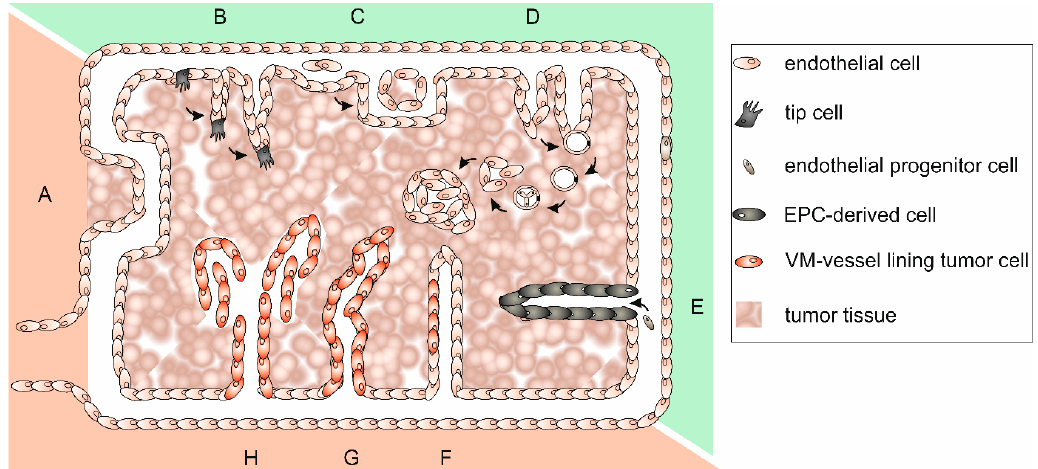
Figure 3. Different types of vascularization allow the blood supply of tumor tissue. Different types of vascularization can occur simultaneously and even merge: ( A ) co-option of preexisting vessels; ( B ) sprouting angiogenesis of endothelial cells; ( C ) intussusceptive angiogenesis; ( D ) glomeruloid angiogenesis; ( E ) vasculogenesis by recruitment of bone marrow-derived endothelial progenitor cells (EPCs); ( F ) in mosaic vessels, patches of tumor cells insert into the endothelium; ( G ) tubular type vasculogenic mimicry (VM) of tumor cells; and ( H ) patterned type VM of tumor cells. While angiogenesis ( B – D ), and vasculogenesis ( E ) depend on proliferation of ECs and bone marrow-derived EPCs, vessel co-option and VM ( F – H ) are EC proliferation-independent ways to support tumor growth. The recruitment of bone marrow-derived EPCs from distant parts of the body impairs radiation therapy, while vessel co-option and VM are unassailable to anti-angiogenic therapy. Vascularization mechanisms that are susceptible to anti-angiogenic therapy are highlighted in green, those that are insusceptible in red.